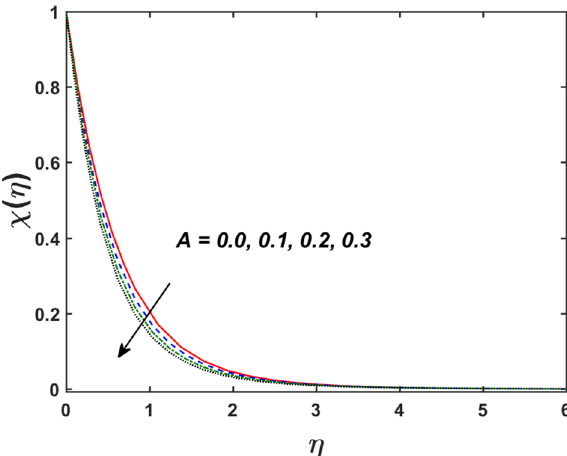
Figure 11. Variation in χ(η) for A and π .